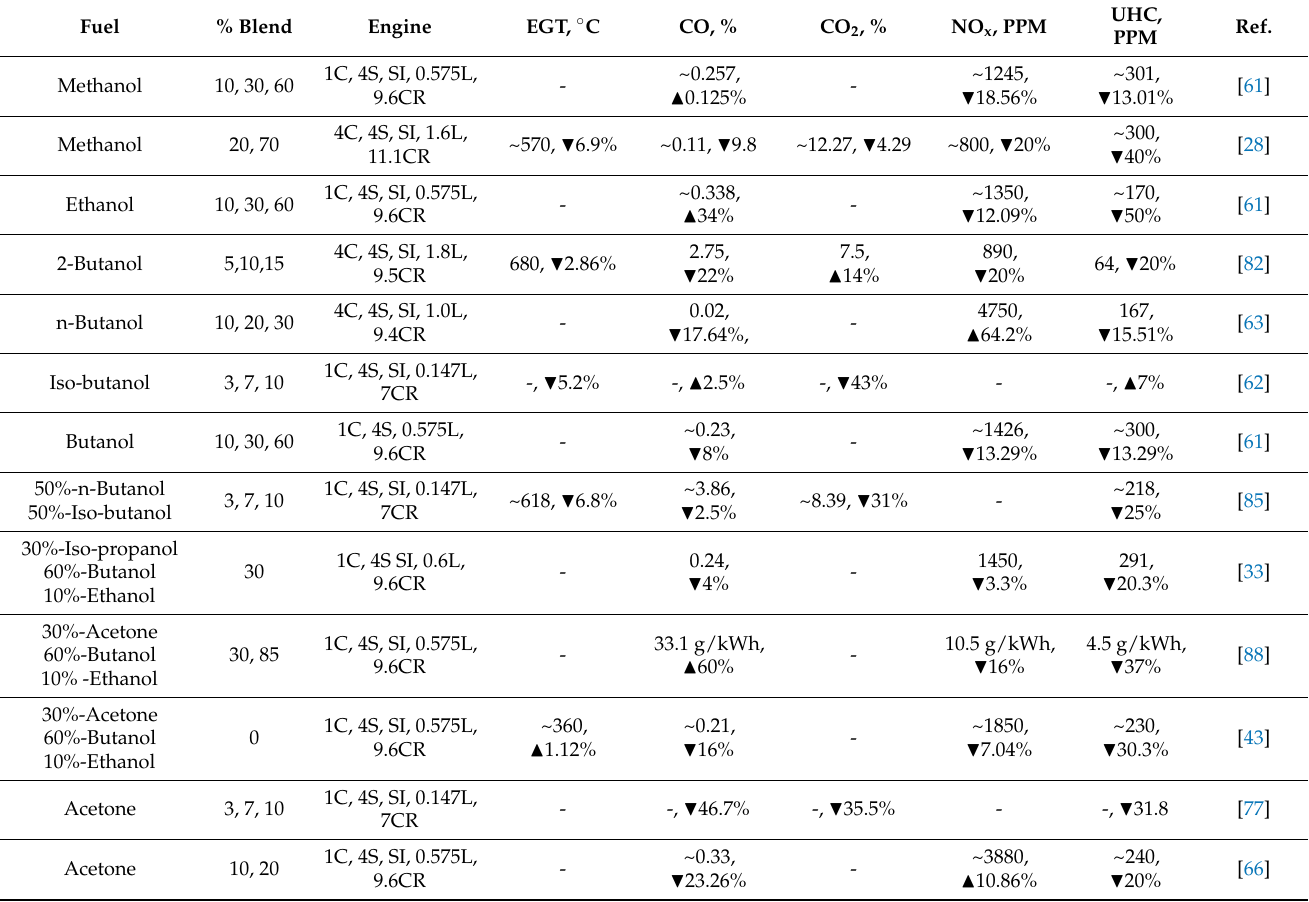
Table 5. Previous findings on emissions of SI engines fueled with alcohol–gasoline blend